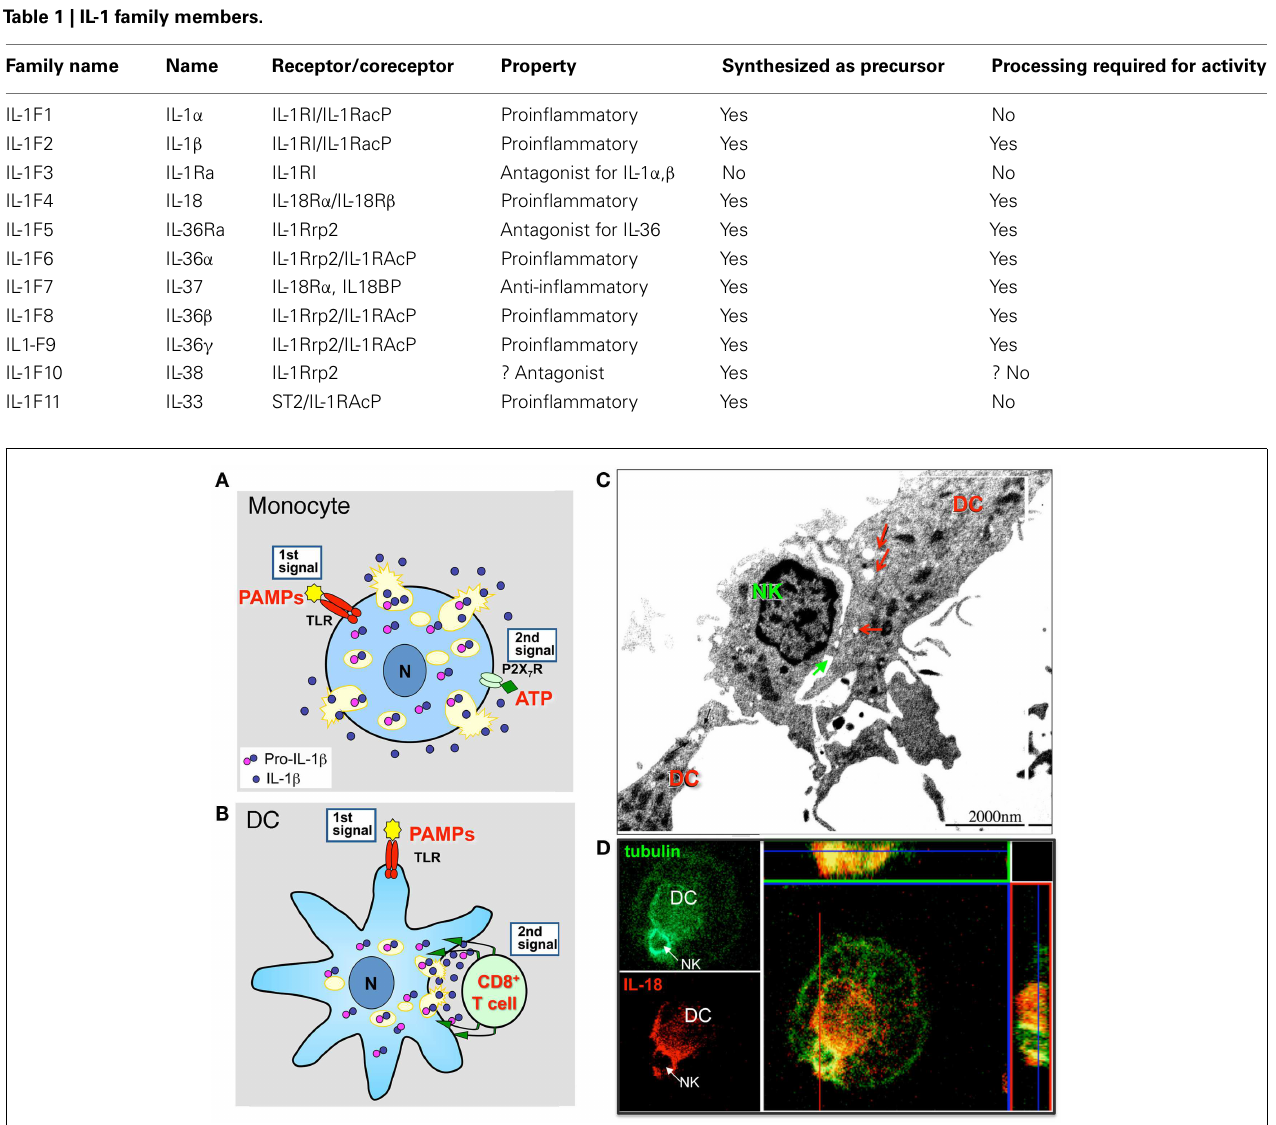
to the intercellular space (immunological synapse) (Gardella et al., 2000b, 2001). A similar mechanism mediates IL-18 secretion in DCs interacting with autologous NK cells (Semino et al., 2005). (C) . Electron microscopy analysis of a DC interacting with a NK cell. Interaction between the two cells occurs primarily in correspondence with DC areas enriched by mitochondria and vesicles (red arrows).The immunological synapse is indicated by the green arrow. (D) Confocal microscopy analysis of tubulin (green) and IL-18 (red) in a DC/NK conjugate after 3h of interaction.The strong co-staining of IL-18 and tubulin in both transversal and sagittal sections indicates that IL-18 from DC polarizes toward the NK/DC synapse and is transported along tubulin filaments. (C,D) : modified from Semino and Rubartelli